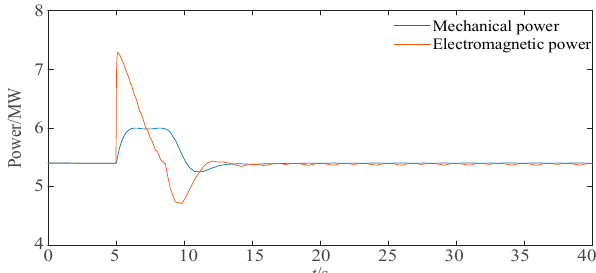
Figure 10. System frequency response results before and after energy storage compensation.